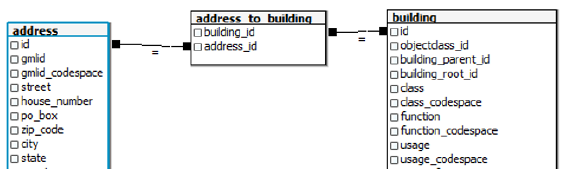
Figure 11: Sample query and related tables and relationships in PostgreSQL